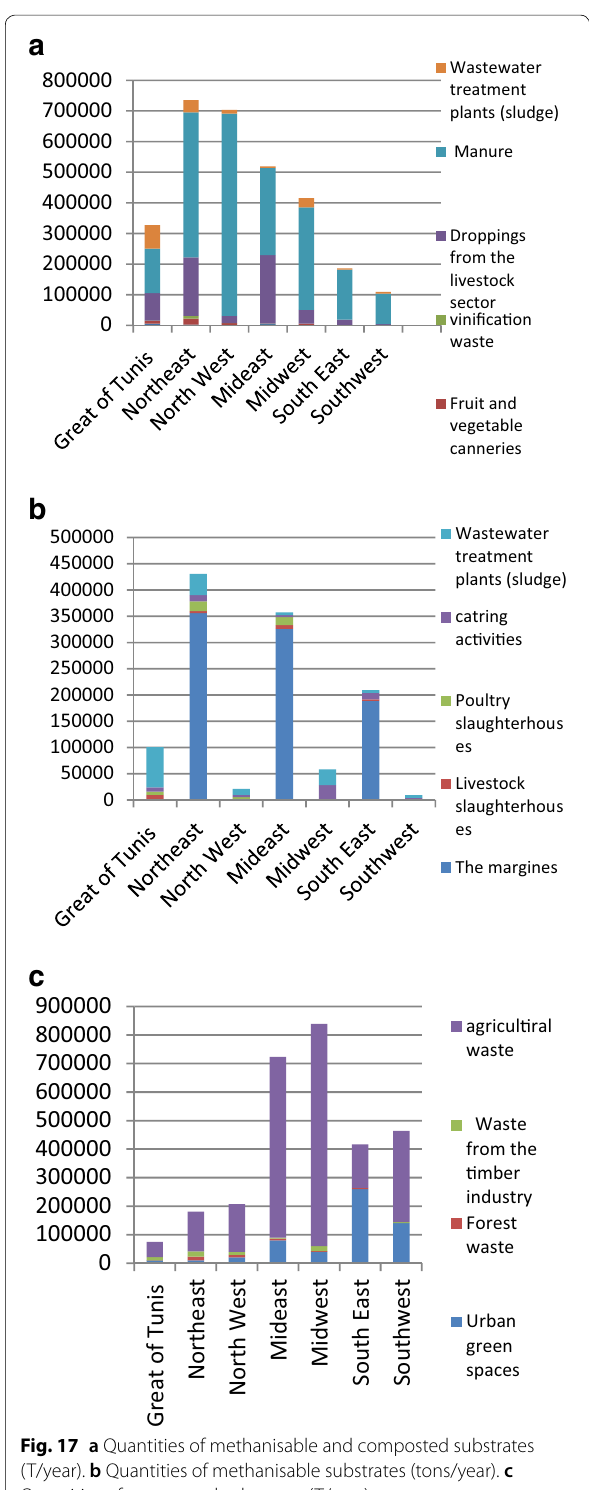
Fig. 17 a Quantities of methanisable and composted substrates (T/year). b Quantities of methanisable substrates (tons/year). c Quantities of composted substrates